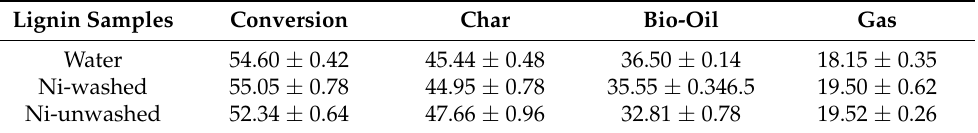
Table 2. Yields of char, bio-oil, and gas products after pyrolysis at 500 ◦ C ( wt.% ). Lignin Samples Conversion Char